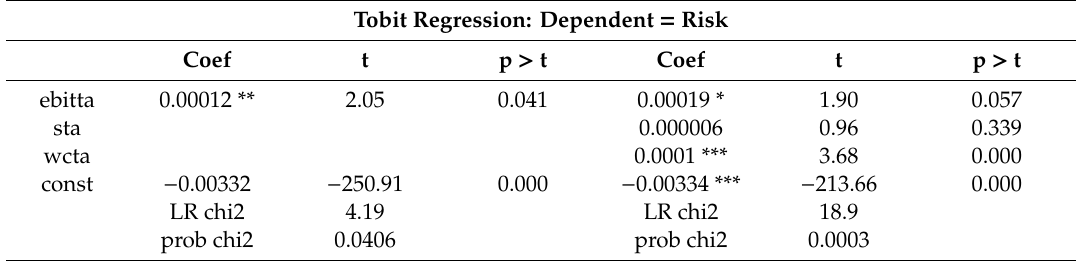
Table 8. Tobit estimation